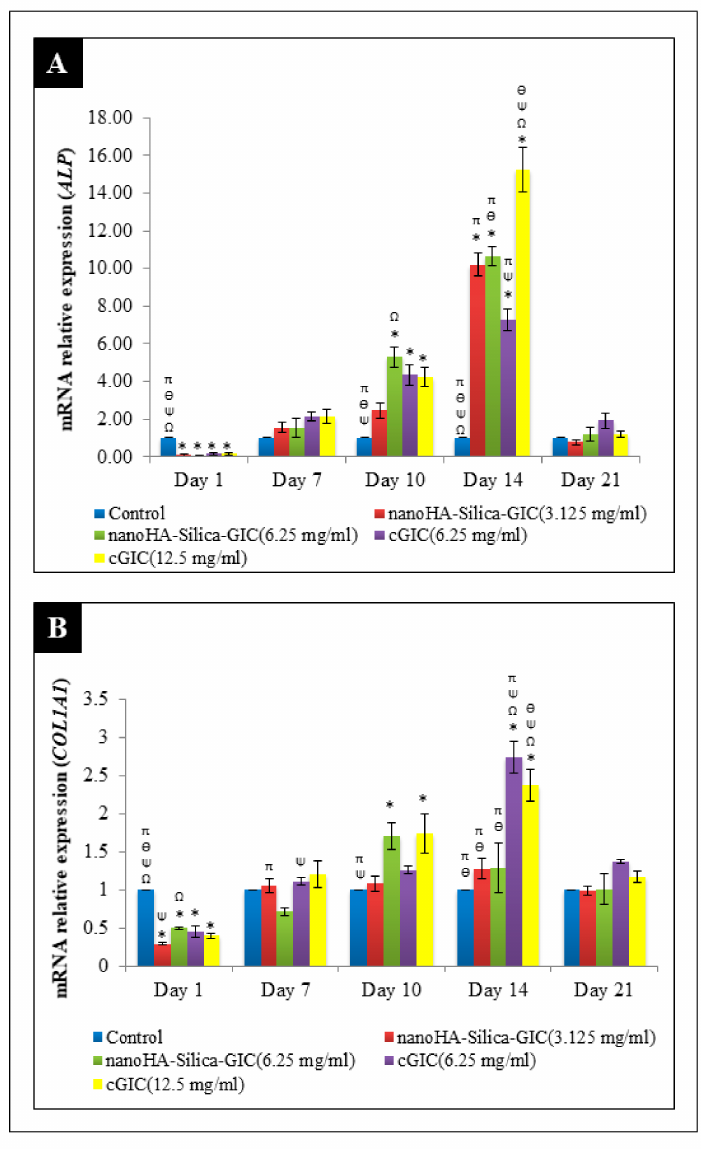
Figure 3. Expression of odontogenic gene markers ( A ) Alkaline phosphatase ( ALP ) and ( B ) Collagen type I ( COL1A1 ) based on real time reverse transcription polymerase chain reaction (rRT–PCR) in dental pulp stem cells (DPSCs). The data are presented as the mean ± standard error of mean (SEM). * indicates a significant di ff erence compared to C (control). Ω indicates a significant di ff erence compared to nanohydroxyapatite-silica-glass ionomer cement (nanoHA–silica–GIC) (3.125 mg / mL). Ψ indicates a significant di ff erence compared to nanoHA–silica–GIC (6.25 mg / mL). Ө indicates a significant di ff erence compared to conventional glass ionomer cement (cGIC) (6.25 mg / mL). π indicates a significant di ff erence compared to cGIC (12.5 mg /